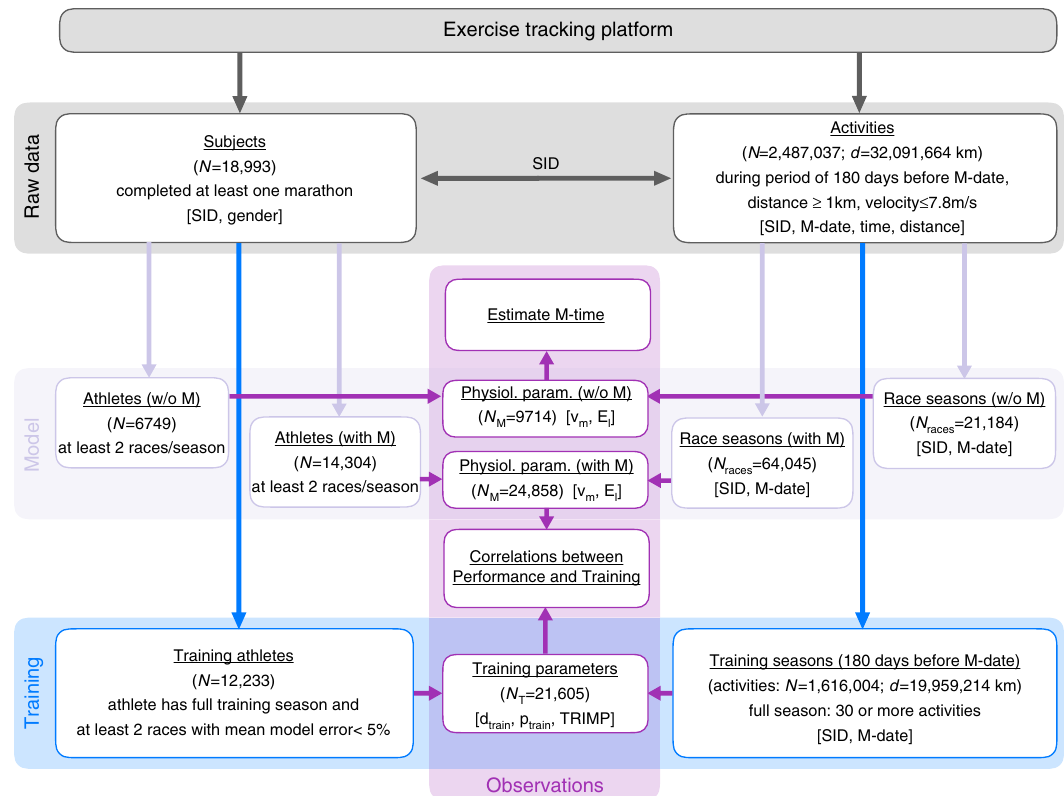
Fig. 1 Flowchart of the exercise data analysis. SID: subject identi fi er, M: marathon, M-date: date of marathon, d: total running distance, “ race season ” : fastest times of an athlete for at least two of the distances 5 km, 10 km, half-marathon, and marathon (±3% to account for GPS tolerance), N races : total number of races, N M : number of successful model fi ts, N T : number of analyzed training seasons for which physiological parameters v m , E l could be obtained and predicted actual race times within a mean error below 5%, “ full training season ” : at least 30 activities during the 180 days before M-date. Table 1 Summary of data sets analyzed.